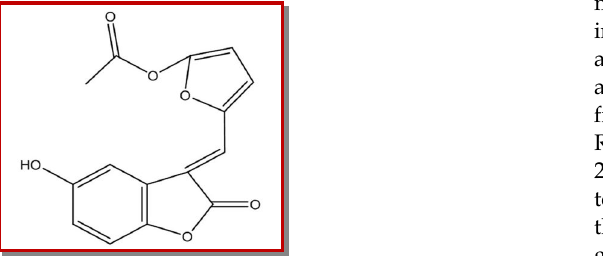
Figure 1: Chemical structure of seneciolactone isolated from Senecio